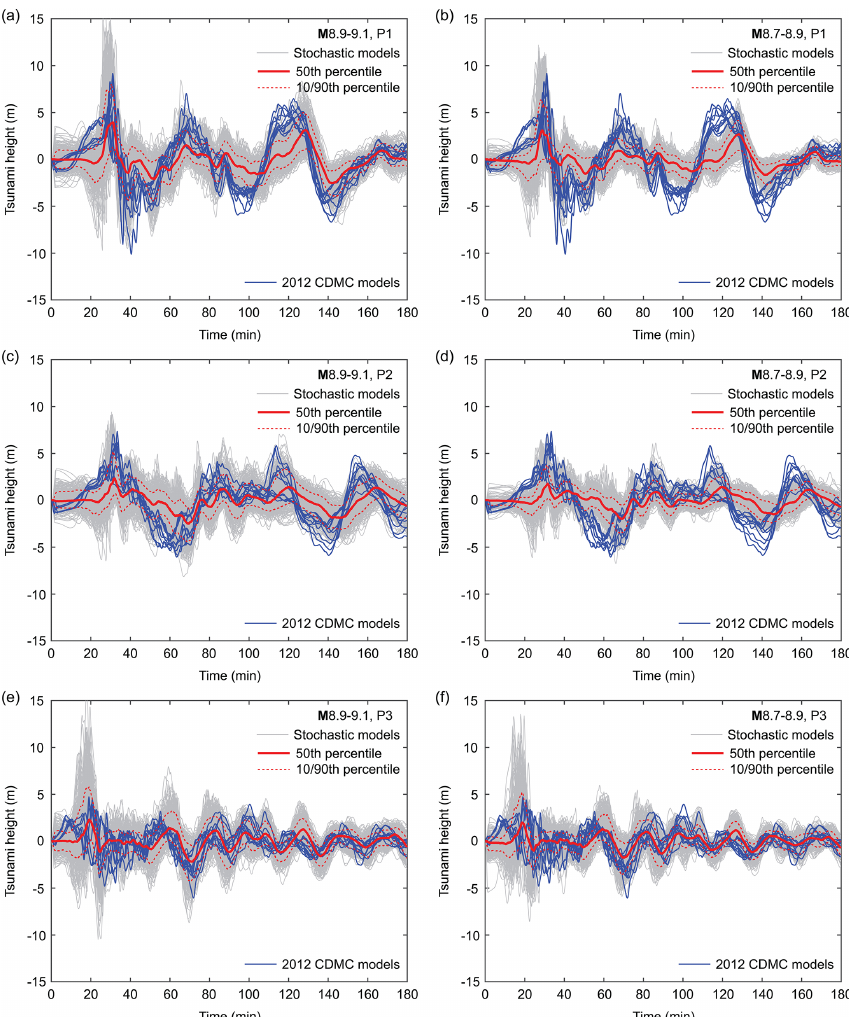
Figure 5. Offshore tsunami wave profiles at P1–P3 (Fig. 4a) for the two magnitude ranges M 8.9–9.1 (a, c, e) and M 8.7–8.9 (b, d, f) . In each figure panel, wave profiles based on 500 stochastic models are shown with grey colours, the 50th percentile curve is shown with solid red line, and the 10th and 90th percentile curves are shown with broken red lines. The blue curves correspond to the simulated wave profiles based on the 2012 CDMC